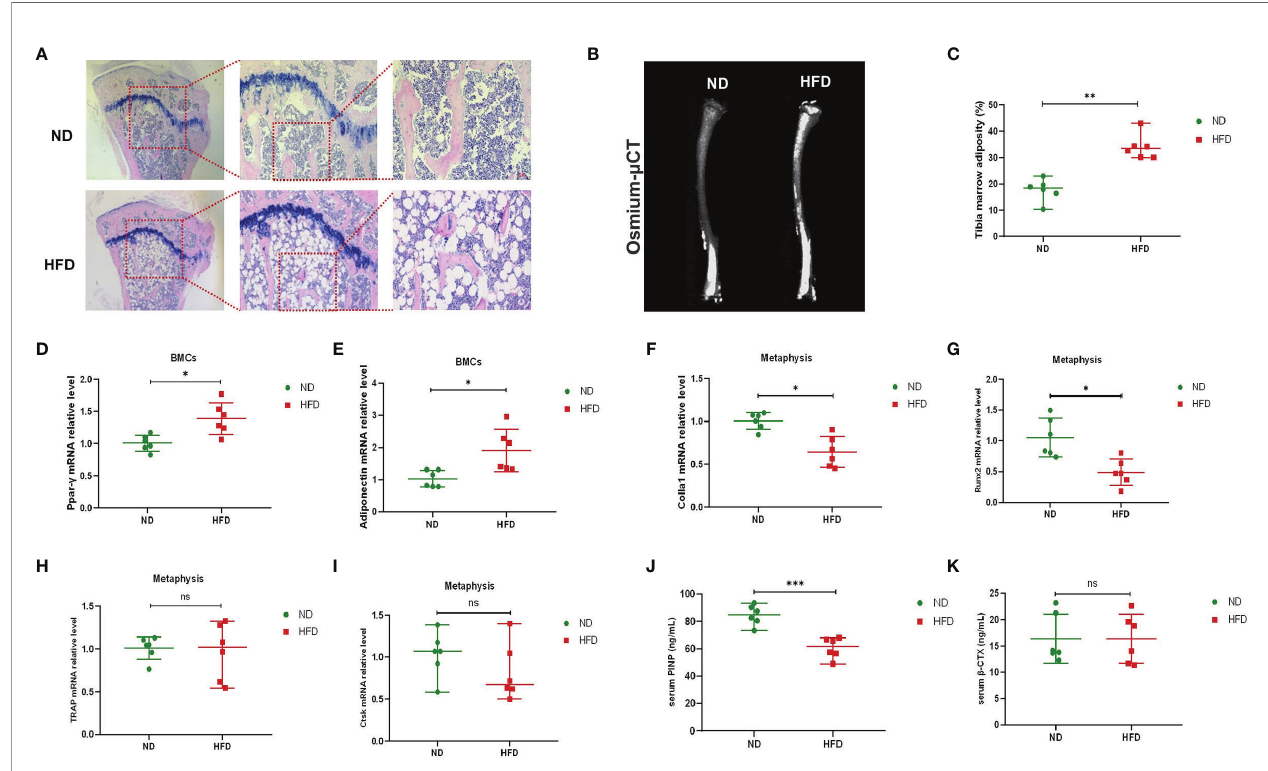
FIGURE 2 | High-fat diet increased bone marrow fat, promoted adipogenesis, and inhibited osteogenesis. (A) Histopathological analysis on bone sections from tibia stained with H&E after ND or HFD treatment. (B) Representative images of BMAT from full-length tibial sagittal plane of ND or HFD mice by micro-CT. (C) Quanti fi cation of the osmium density in tibia sagittal plane (n = 6). (D, E) mRNA levels of adipogenic genes in BMCs of ND or HFD mice (n = 6). (F, G) mRNA levels of osteoblastic genes in BMCs of ND or HFD mice (n = 6). (H, I) mRNA levels of osteoclastic genes in the metaphysis of ND or HFD mice (n = 6). (J, K) Serum levels of bone turnover biomarkers (n = 6). Data were expressed as mean ± SD. * P < 0.05, ** P < 0.01, *** P < 0.001, ns, no signi fi